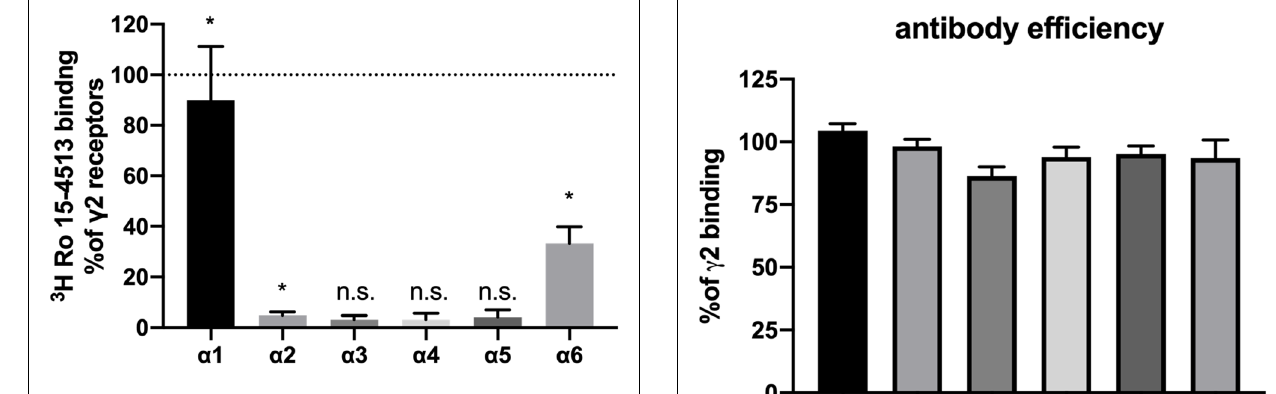
FIGURE 1 | α -subunits found in γ 2-containing receptors in rat cerebellum. GABAA receptors were extracted from rat cerebellum, precipitated with subunit specific antibodies, and quantified using 3 H-Ro 15-4513 binding. Nonspecific binding was analyzed by the addition of 50 µ M Ro 15-1788. Results are expressed concerning values obtained with parallel precipitation with specific anti- γ 2 antibody. Shown are the mean ± SD of three independent experiments performed in duplicates each. Data were analyzed statistically, if they are significantly different from 0, following a one-sample t and Wilcoxon test ( ∗ p < 0.05; ns: p > 0.05; α 1: p = 0.0181; α 2: p = 0.0260; α 6: p = 0.0129; α 3, α 4 and α 5: p > 0.05).